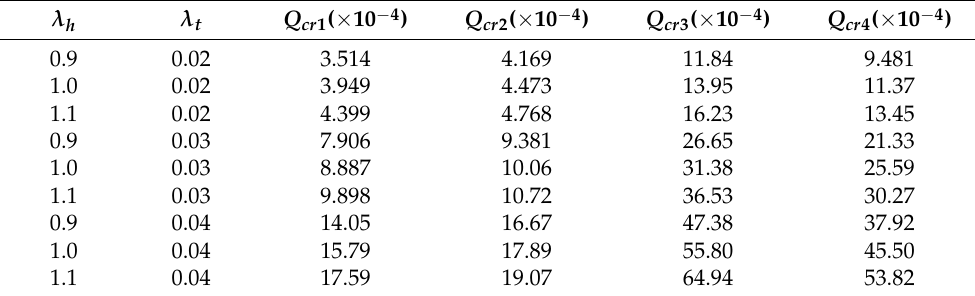
Table 4. Four critical loads under different λ h and λ t ( β = ± 0.1 ).